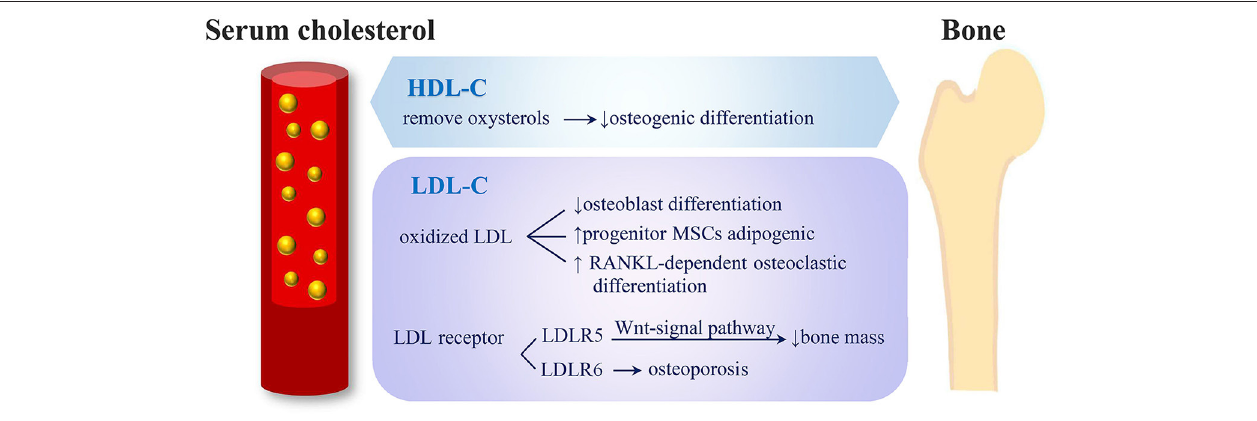
FIGURE 4 | Potential mechanisms of serum cholesterol on bone metabolism. (1) HDL-C removes oxysterols from peripheral tissues and shows negative effects on osteogenic differentiation. (2) LDL oxidation products inhibit osteoblasts’ differentiation, direct progenitor MSCs to undergo adipogenic instead of osteogenic differentiation and induce RANKL-dependent osteoclastic differentiation. (3) LRP5 exerts an anabolic action on bone through Wnt-signal pathway and causes low bone mass. (4) Mutation of LRP6 were related to severe osteoporosis (HDL-C, high-density lipoprotein cholesterol; LDL-C, low-density lipoprotein cholesterol; MSC, mesenchymal stem cells; RANKL, receptor activator of nuclear factor-k B ligand; LRP, low-density lipoprotein cholesterol receptor-related protein).